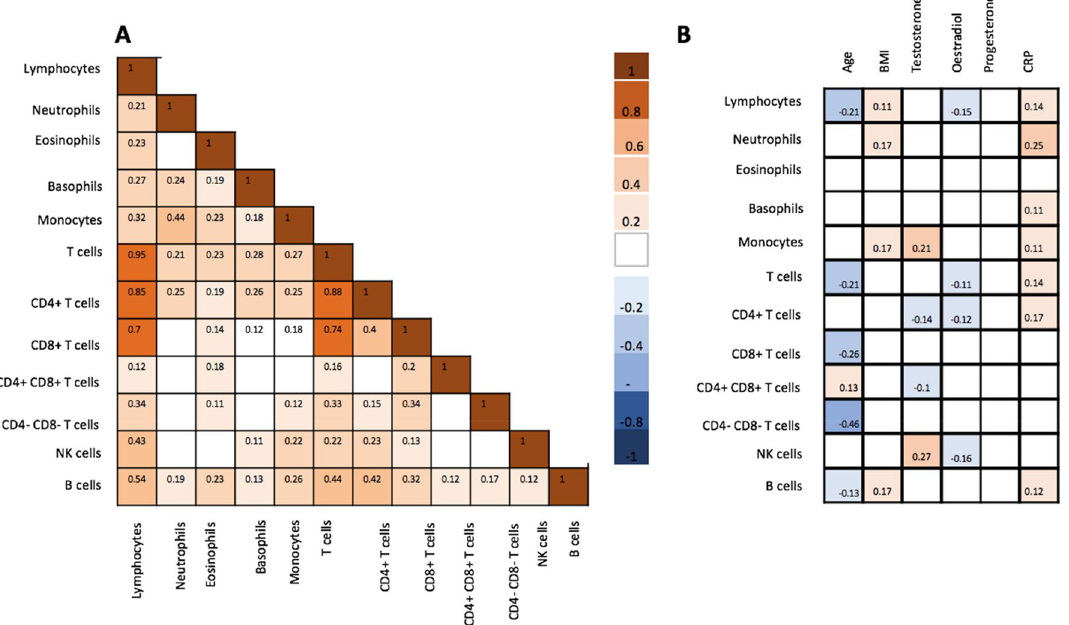
Figure 1. Correlation of baseline immunological parameters and phenotype (age, BMI) at baseline. ( A ) Correlation between the all leukocyte subsets. ( B ). Correlation between the all leukocyte subsets and phenotypic characteristics such as age, BMI, hormones and CRP. Spearman’s rank correlation was used. If the correlation was not significant, a blank square is shown. Colored squares indicate when a correlation was significant ( p < 0.05).